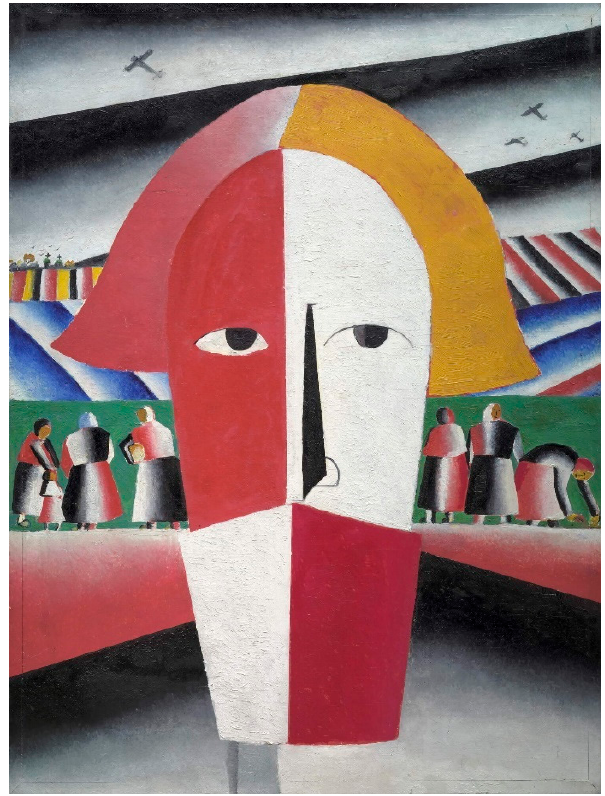
Figure 3. Kazimir Malevich. Head of a peasant.